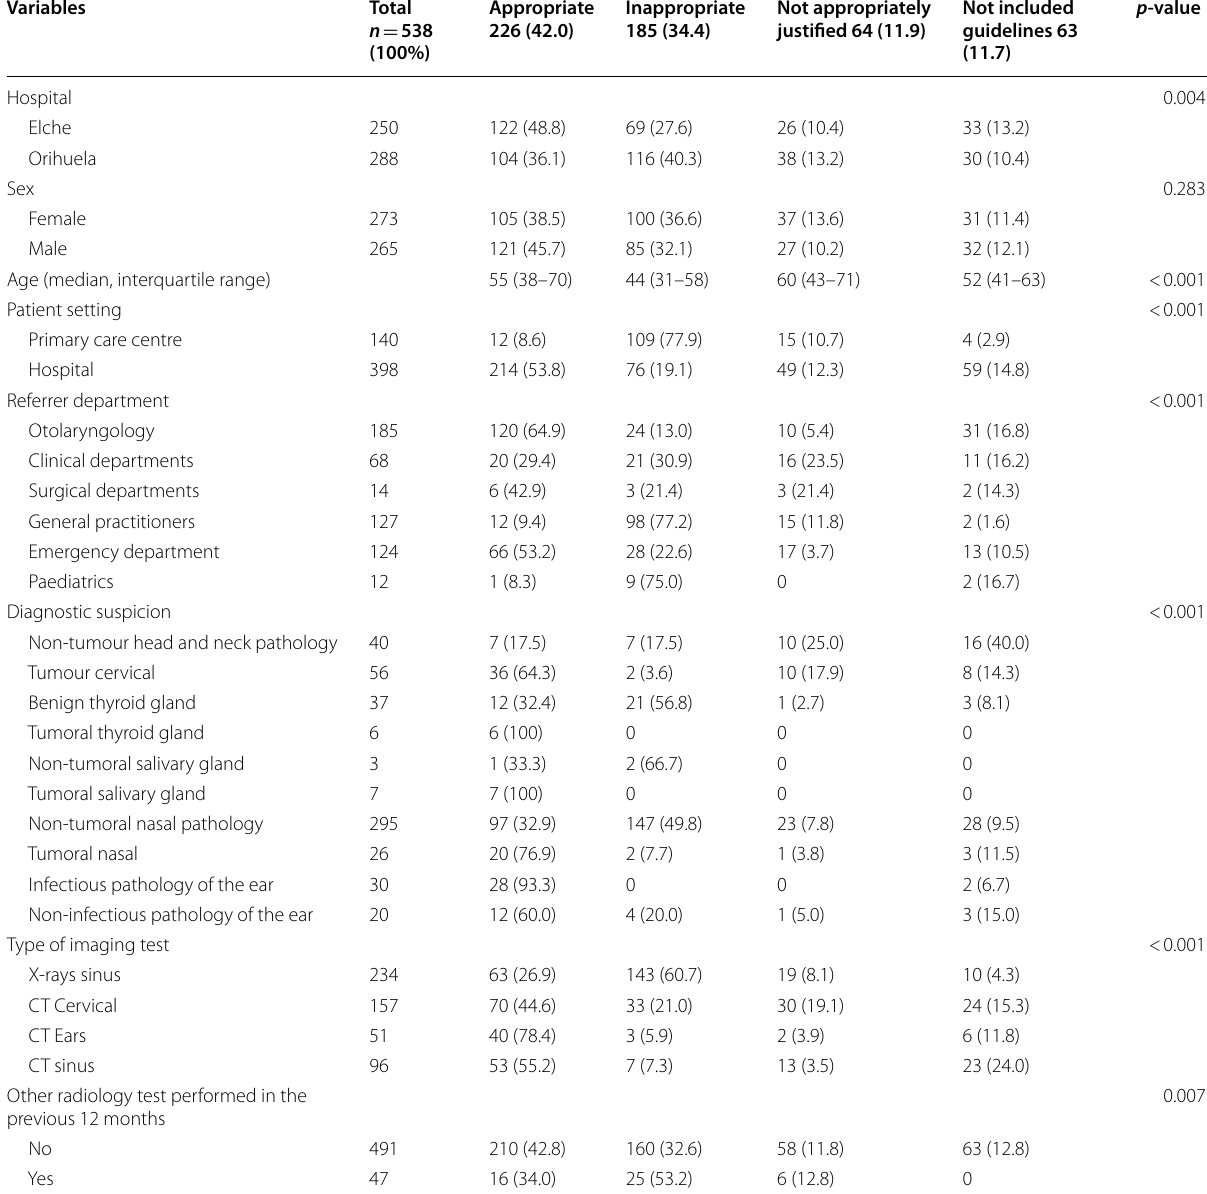
Table 1 Description of the study variables according to the classification of the imaging test